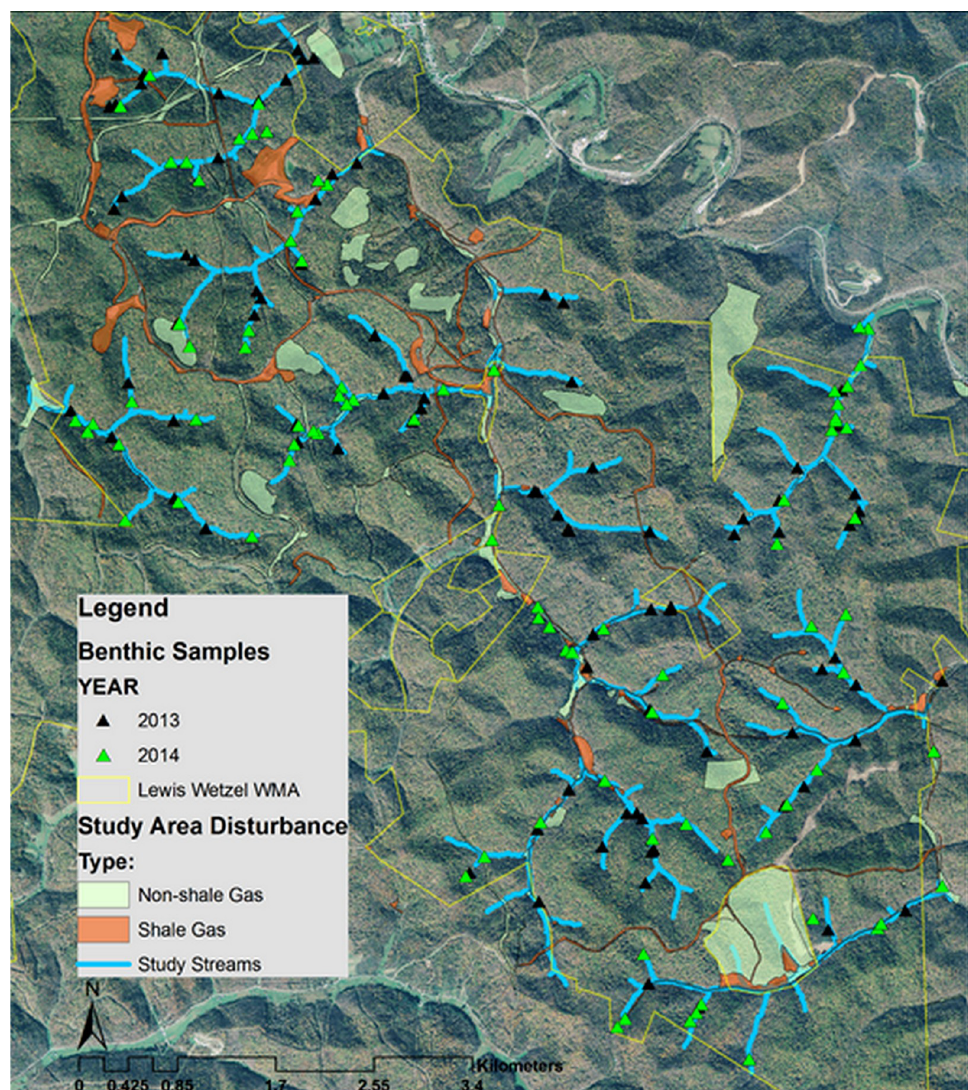
Fig 1. Location of study streams, benthic sampling locations, and stream reaches disturbed by shale gas development during 2013–2014 on the Lewis Wetzel Wildlife Management Area in northwestern West Virginia. The larger light green patches of non-shale gas disturbance are primarily timber harvests with partial canopy